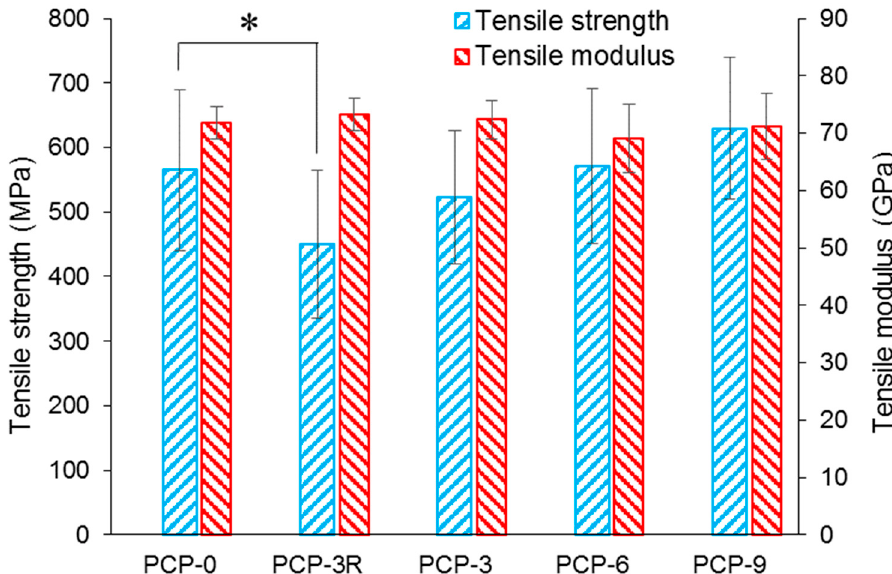
Figure 1. Mechanical properties (tensile strength and modulus) of coated/uncoated fibres ( n = 30). The statistical significance of the paired t -test is indicated (*) at the p < 0.05 level.